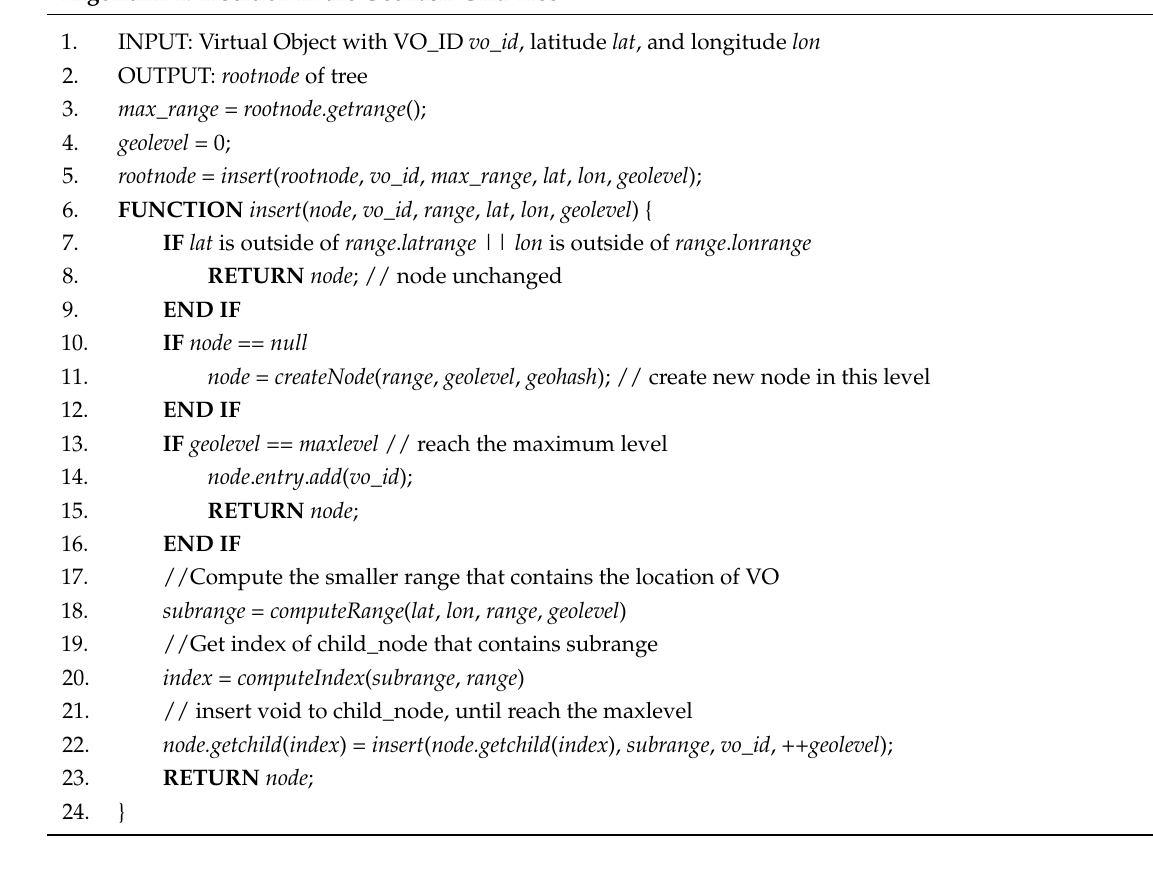
Algorithm 1: Insertion in the Geohash-Grid